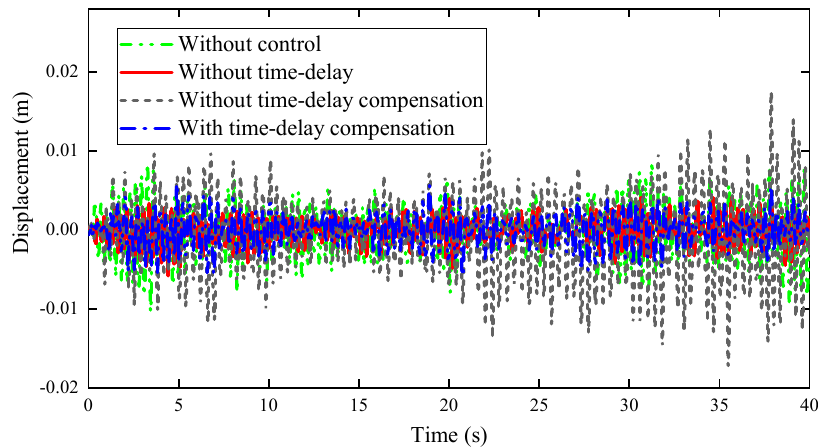
Figure 12. The experimental displacements at mid-span with 0.11 s time-delay under random excitation.